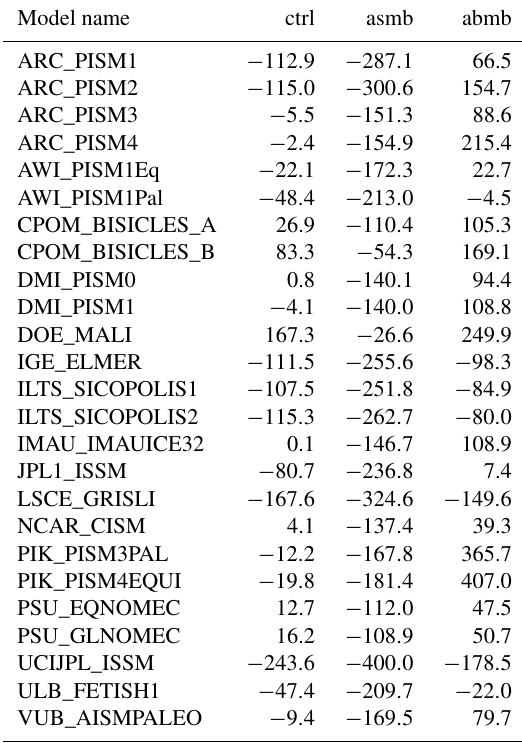
Table D1. Antarctic contribution to sea level (mm sea level equiva- lent, positive for sea level increase) at the end of the 100-year sim- ulation for the three experiments and all